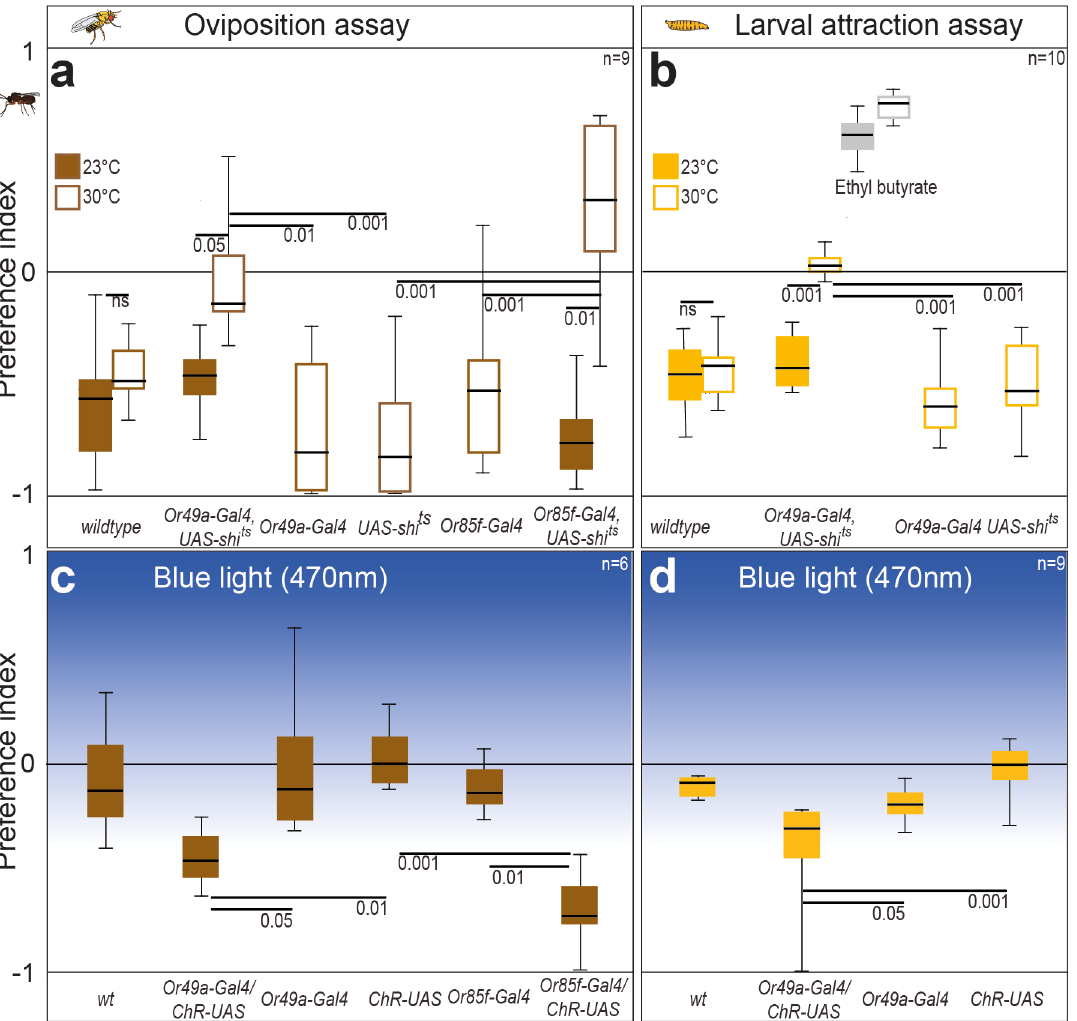
Fig 4. The ab10B neuron is necessary and sufficient to govern oviposition avoidance and larval avoidance behavior in D . melanogaster . ( A ) Preference indices of ovipositing wildtype flies, flies expressing Shibire ts in ab10B neuron, and corresponding parental lines at restrictive (30°C) and permissive (23°C) temperature when tested with wash of L . boulardi . ( B ) Preference indices of the same fly lines when tested in the larval assay. Attraction to ethyl butyrate (grey bars) depict that loss of odor-guided behavior in larvae expressing Shibire ts in ab10B neuron is odorant specific. ( C ) Light preference of ovipositing wildtype flies, flies expressing channelrhodopsin in ab10B neuron, and corresponding parental lines. ( D ) Light preferences of the same fly lines when tested in the larval assay. ( A – D ) Bar plots indicate minimum and maximum values (whiskers), the upper and lower quartiles (boxes), and the median values (bold black line). Groups were compared by the Kruskal Wallis test with a Dunn ’ s multiple comparison for selected pairs. For calculation of preference indices, see Fig 1.